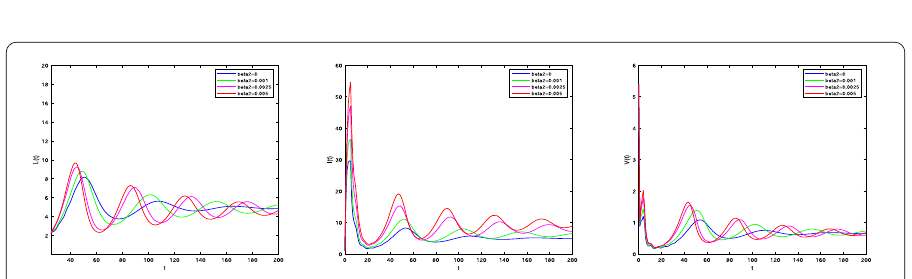
Figure 5 The effect of β 2 on the dynamical behavior of model (1)